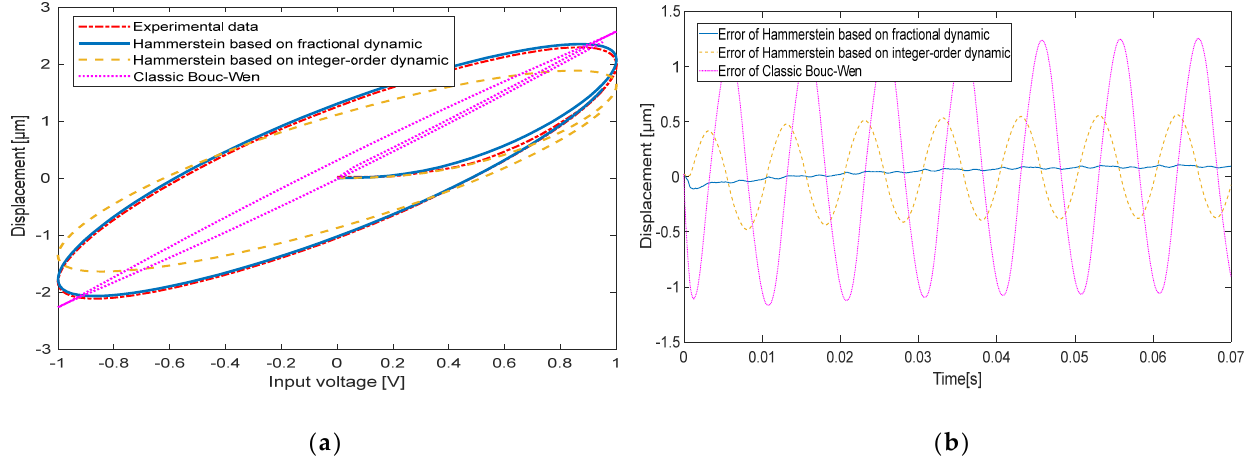
Figure 11. The comparison between experimental data and the Hammerstein model at 100 Hz: ( a ) Hysteresis loop; ( b ) Time curve.